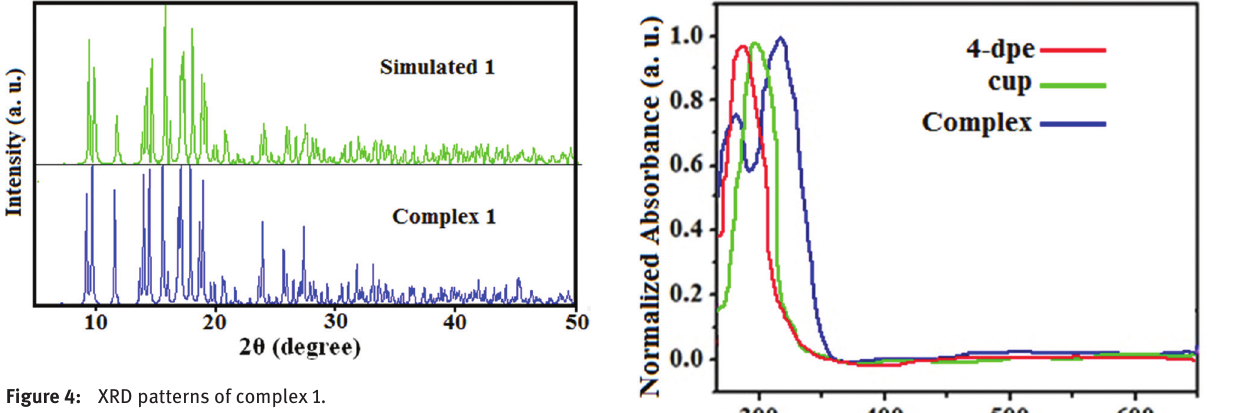
Figure 4: XRD patterns of complex 1.